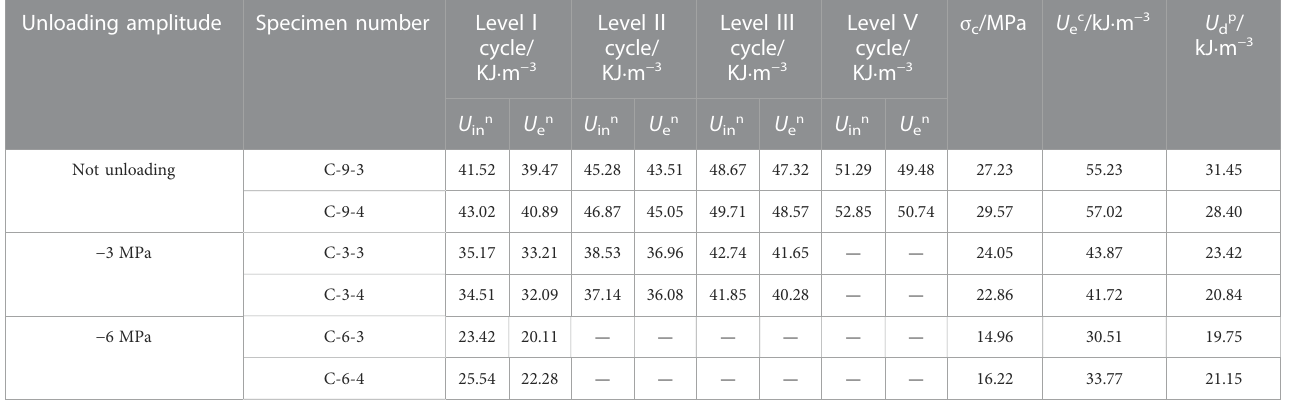
TABLE 4 Cyclic loading and unloading test results of coal specimens under varying amplitude unloading. Unloading